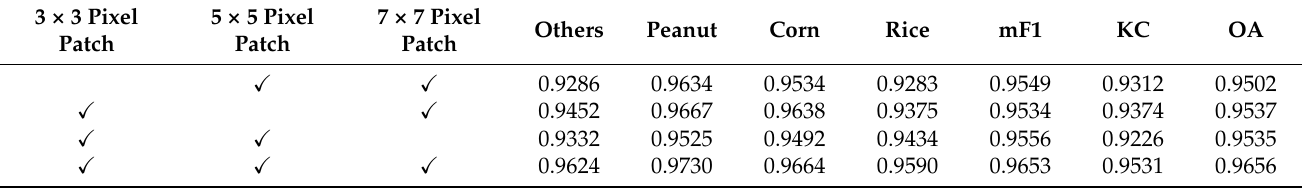
Table 9. Experimental results for exploring the contribution of different size of patches across experiments where one plot size is